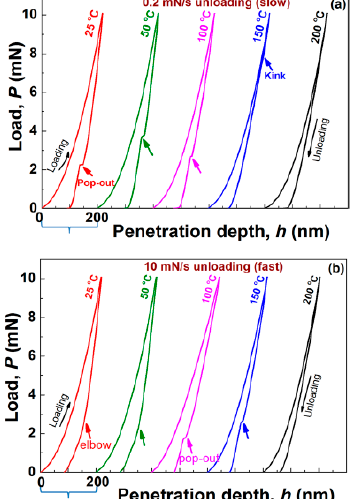
Figure 3. Temperature-dependence of phase-transition during indentation: load-depth curves obtained on diamond cubic silicon (Si-I) at different temperatures for ( a ) 0.2 mN/s and ( b ) 10 mN/s unloading rates. The loading rate of 1 mN/s and holding period of 5 s were the same in all experiments [15]. (In this Figure the load is denoted as P, instead of F.). Reproduced with permission from [15]. Copyright 2015, AIP Publishing